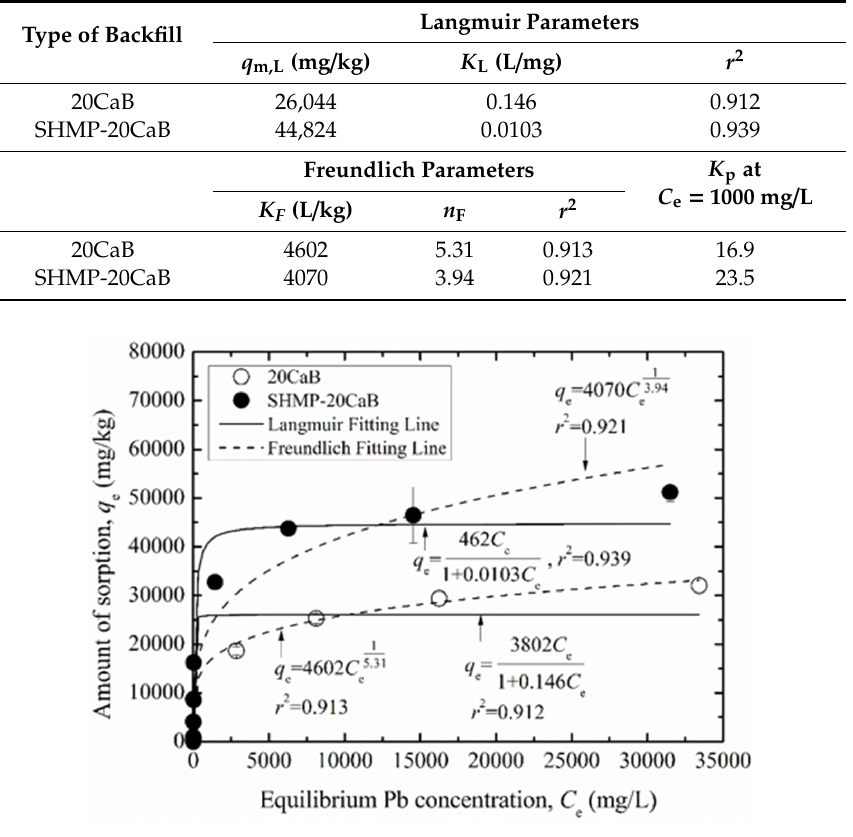
Table 2. Summary of best-fit Langmuir and Freundlich parameters for Pb sorption in backfill mixtures.